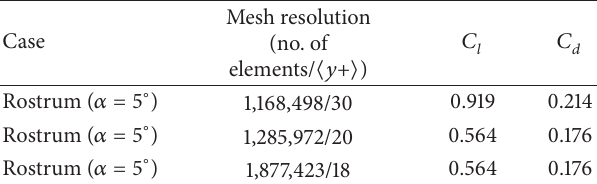
Table 2: Mesh independence